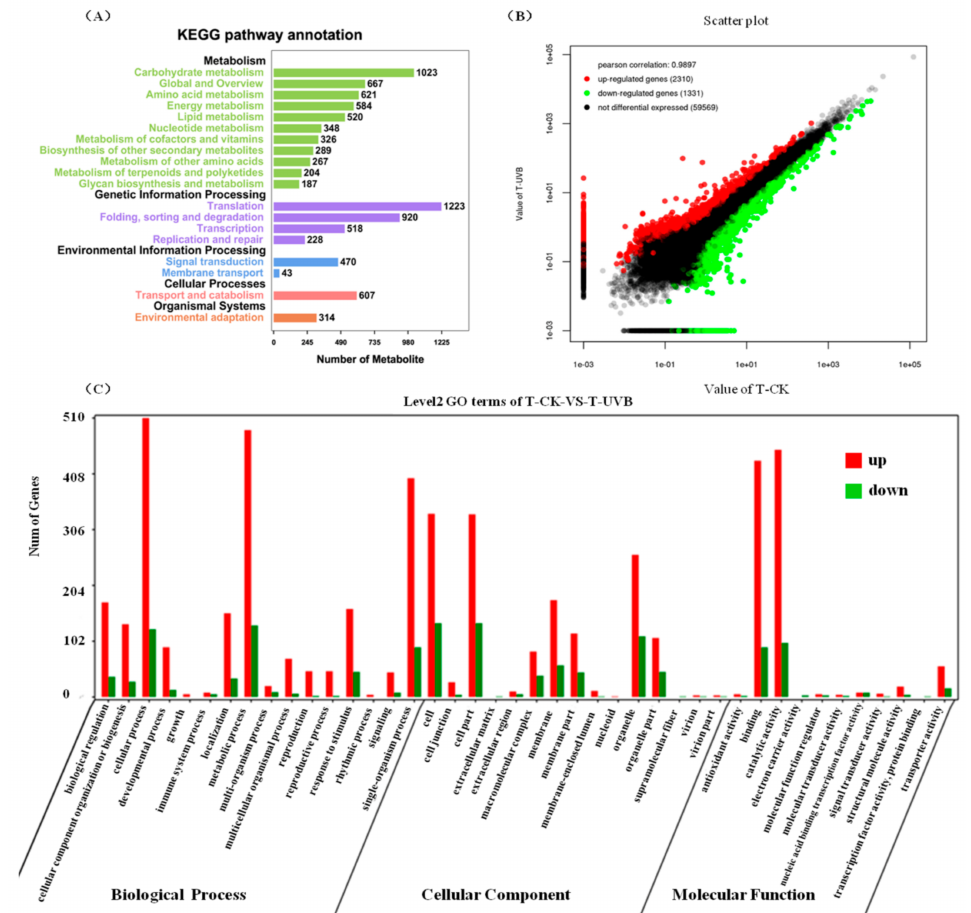
Figure 4. Functional annotations of transcribed conserved domain (CD)-containing sequences and differentially expressed volcano plots between UV-B radiation and CK. ( A ) Kyoto Encyclopedia of Genes and Genomes (KEGG) classification of transcribed CD-containing sequences in M. himalaica . ( B ) Differentially expressed volcano plots between UV-B radiation and CK. In this study, the MARS (MA-plot-based method with Random sampling model) model in the DEGseq v1.20.0 package (http://bioconductor.org/packages/release/bioc/html/DEGseq.html) was used to confirm whether there is a difference between different treatments based on the criteria both |fold change| > 2 and p -value < 0.05. ( C ) Go functional annotation of different expression unigenes between UV-B radiation and